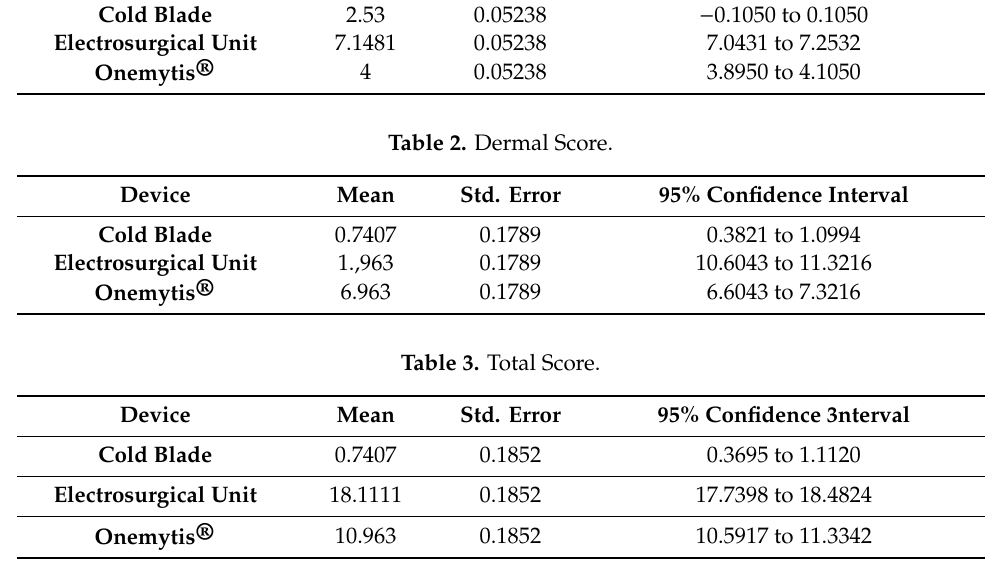
Figure 5. Dermal Score.